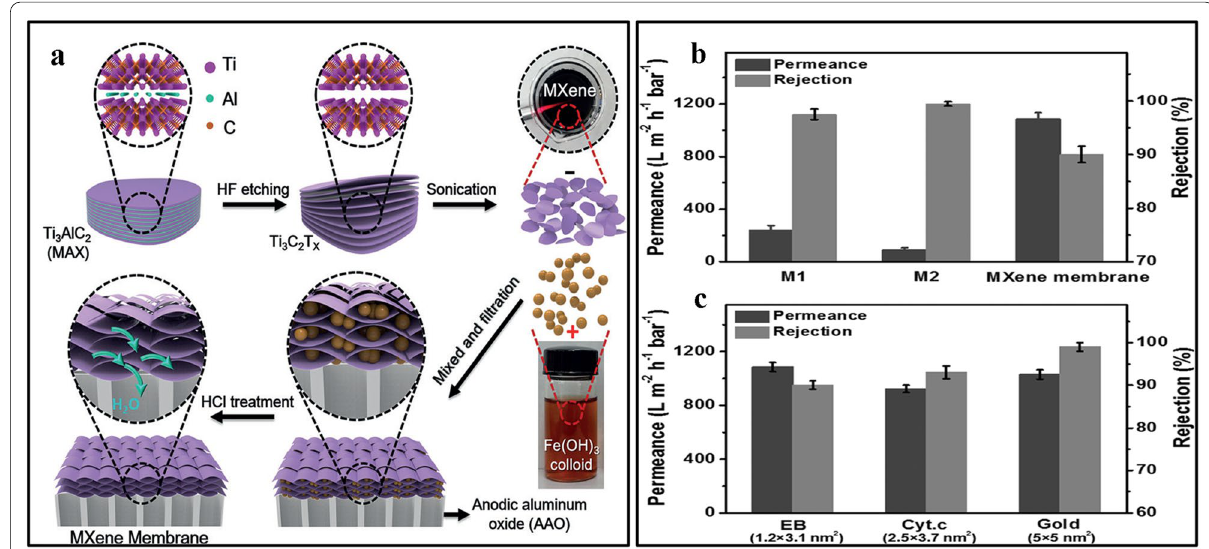
Fig. 4 a Schematic diagram depicting the assembly of porous MXene membrane with Fe (OH) 3 nanoparticles as template. b analytical comparison of M1, M2, and MXene membranes projected for EB molecules; c separation efficiency of MXene membranes estimated for various molecules of different sizes. Reprint with permission [43]. Copyright 2017,Wiley–VCH Verlag GmbH & Co. KGaA,